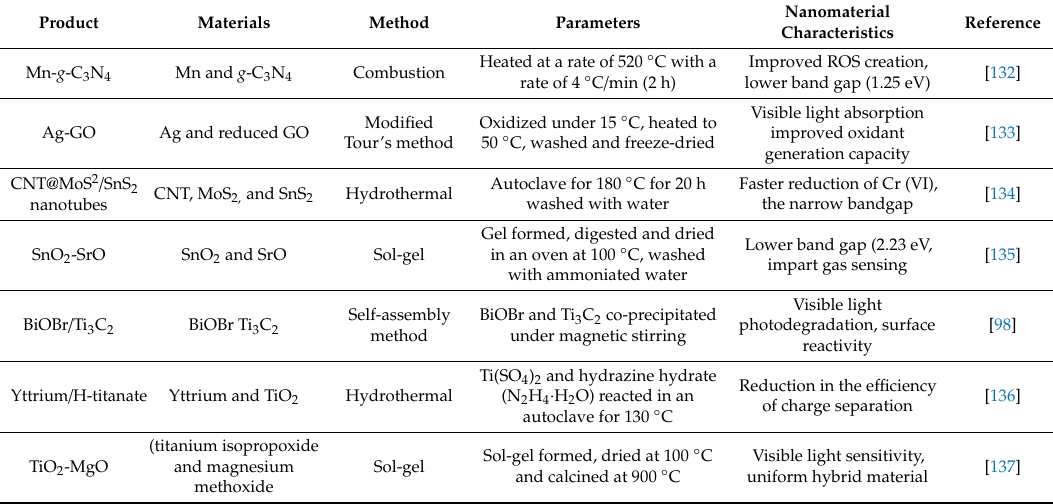
Table 3. Synthesis of hybrid nanomaterials using di ff erent